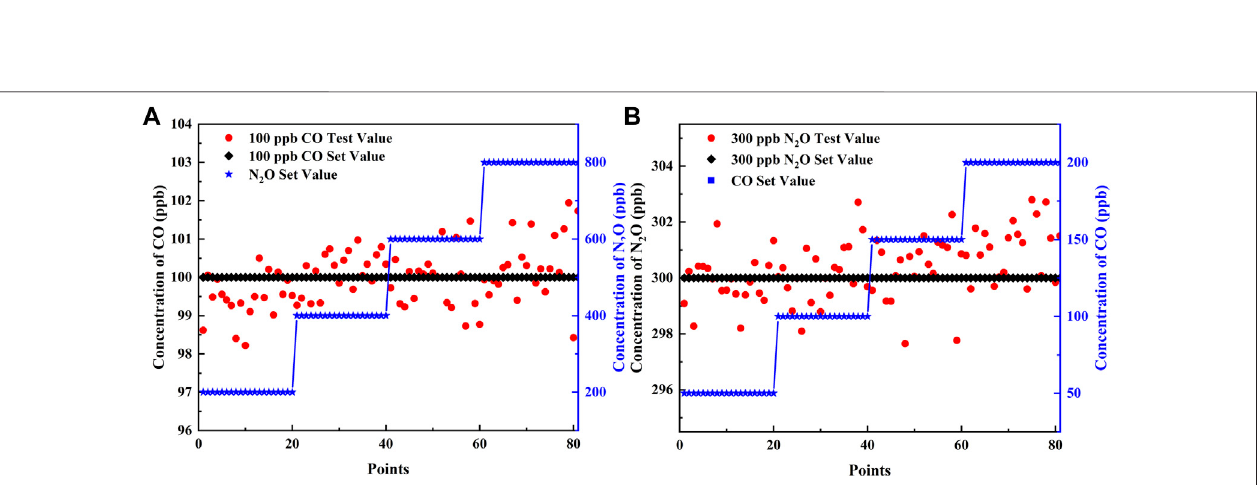
FIGURE 7 | (A) Different concentrations of N 2 O interfere with 100 ppb of CO. (B) Different concentrations of CO interfere with 300 ppb of N 2 O.